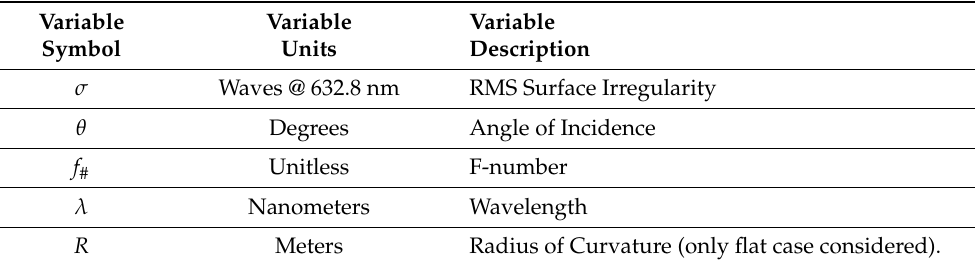
Table 5. Parametric Variables for Performance